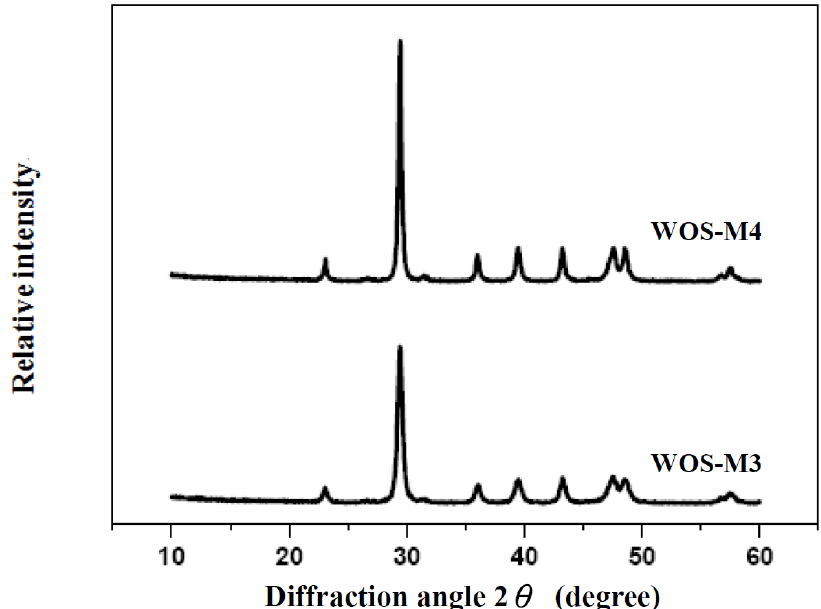
Figure 1. X-ray diffraction (XRD) diffractograms of some milling shell powders ( i.e. , WOS-M3 and